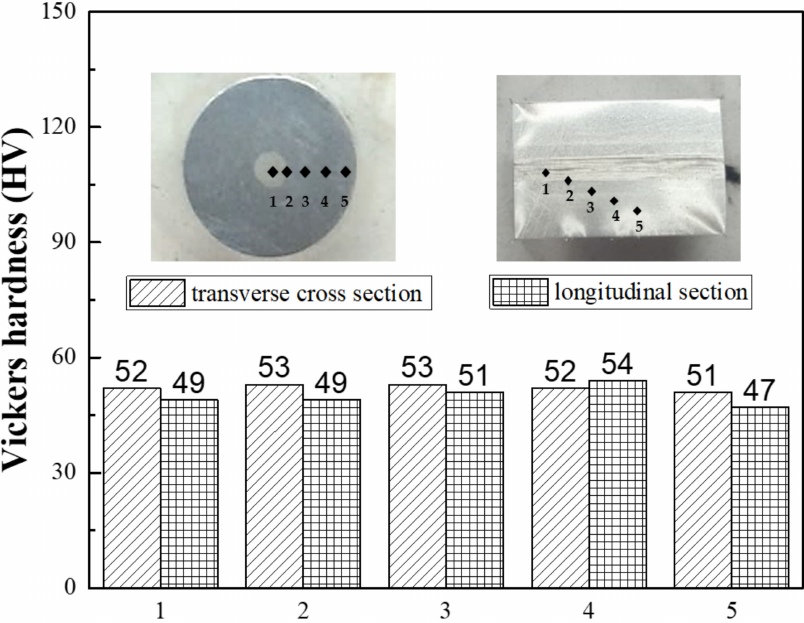
Figure 8. Vickers hardness graph measured on the transverse cross-section and longitudinal sections of the FGM at five regions from the center (Al3003) to Al6063, including the interface between Al3003 and